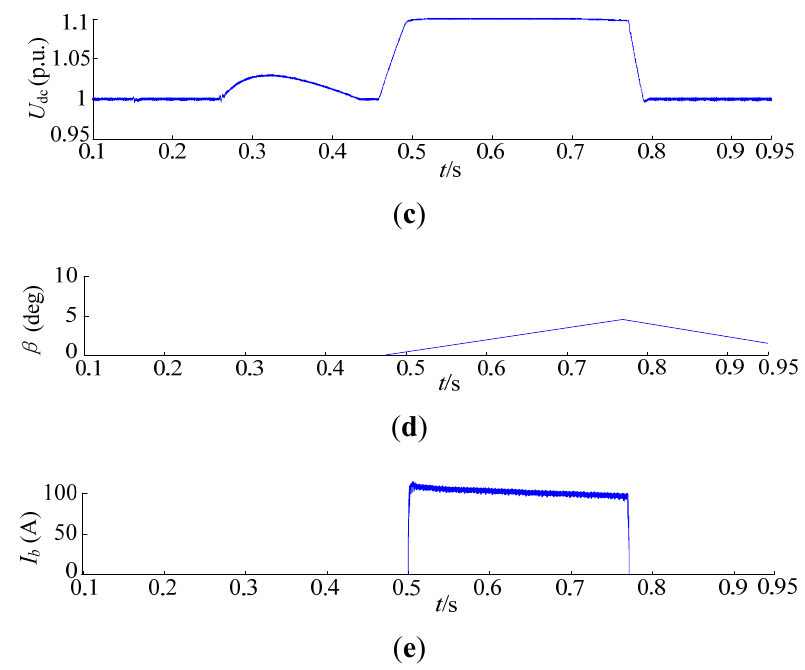
Figure 17. The simulation results for the PMSG WT hierarchical control during power grid faults. ( a ) Generator rotor speed; ( b ) Active power output of the MSC; ( c ) PMSG DC-link voltage; ( d ) WT pitch angle; ( e ) DC chopper